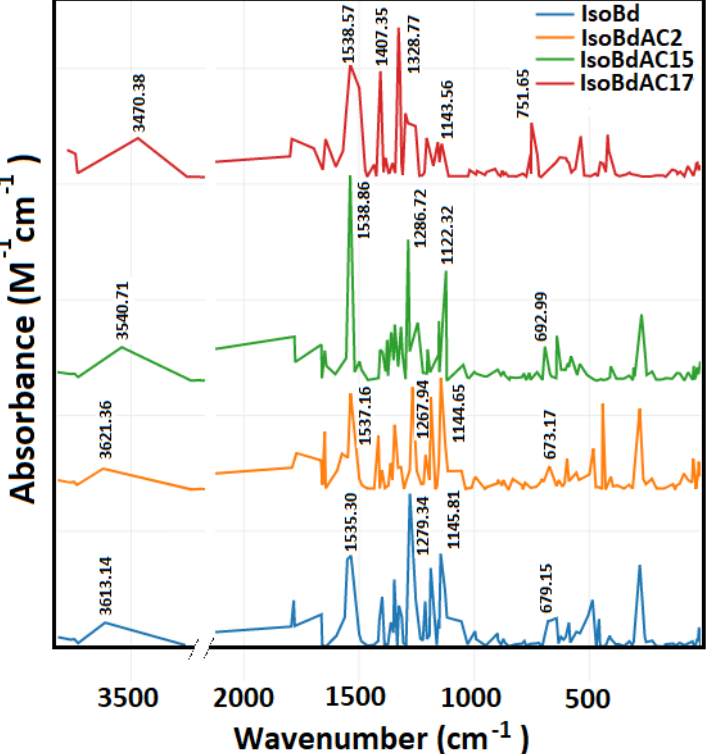
Figure 2. Parent Isobetanidin (IsoBd) and their anios IsoBdAC2, IsoBdAC15, and